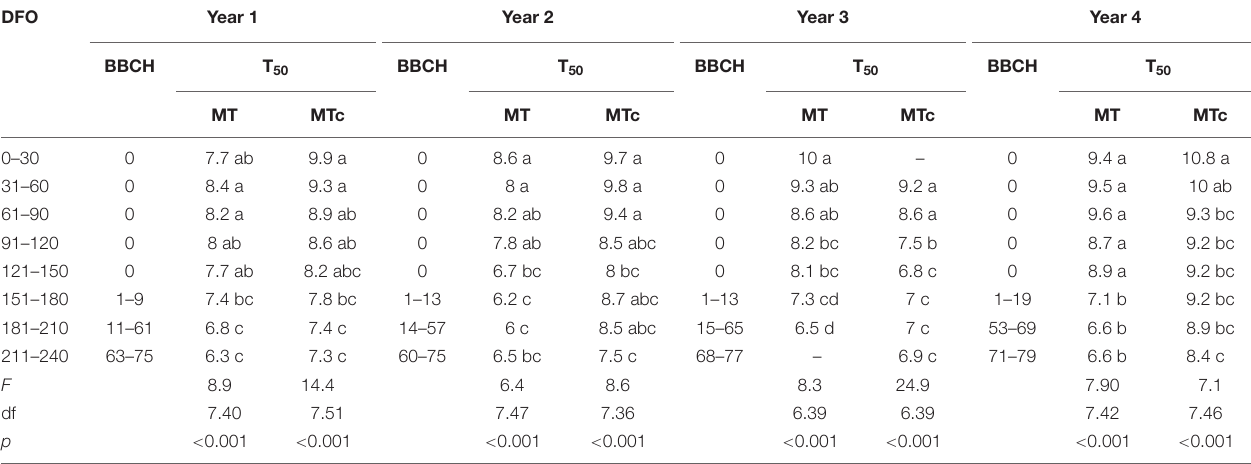
FIGURE 4 | Results of viability assay. Pictures of living (A–C) and dead, blue-colored, oospores (D–F) . Bar = 25 µ m. OO = ooplast; LG = lipid globules. (G) Percentages of germination (bar) and viable oospores (line) of MTc samples. Bars in the line graph represent standard deviation. TABLE 2 | Phenological stages of grapevine (BBCH scale a ) and average T 50 values (measured in days) recorded each year by the oospores overwintered in natural (MT) and controlled conditions (MTc) at each DFO interval and results of statistical analysis (ANOVA and multiple comparison of mean values b ).